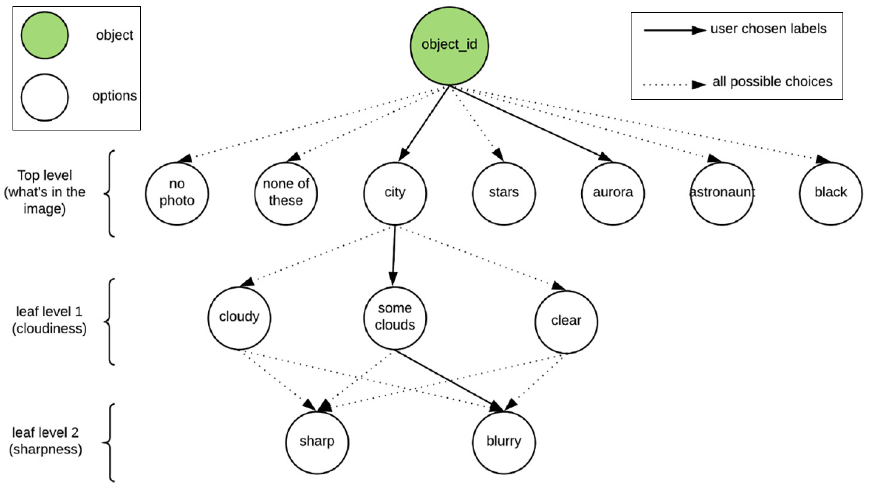
Figure 4. Representation of dark skies work fl ow from cities at